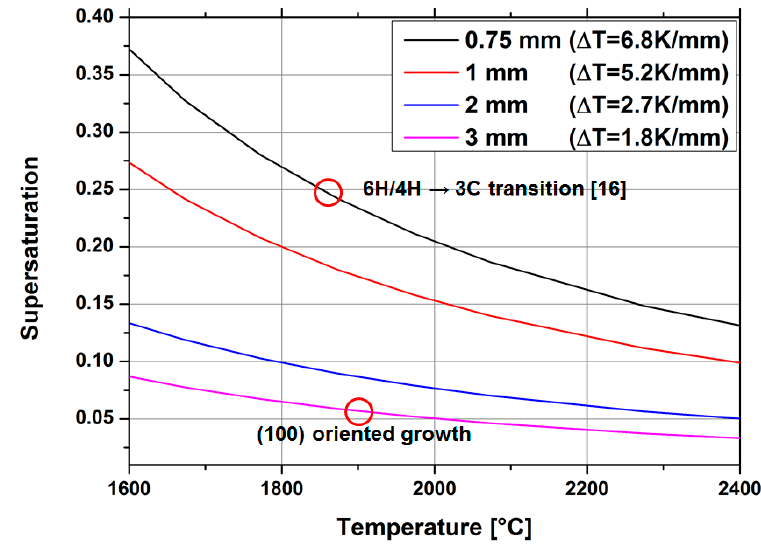
Figure 6. Calculated supersaturation for the growth-limiting gas species SiC 2 as a function of temperature for four different source-to-substrate distances. Highlighted areas are extracted from the literature and experiments were performed on (100)-oriented material.